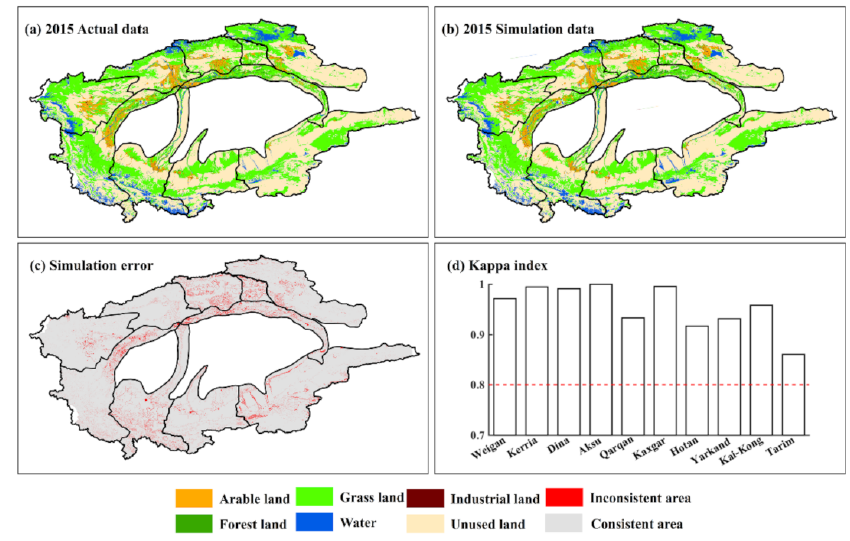
Figure 7. Comparisons of measured ( a ) and simulated ( b ) land-use maps of the Tarim River Basin in 2015, along with verification of forecast accuracy; ( c ) The simulation error between 1990 and 2015; ( d ) the Kappa index for each river basin.